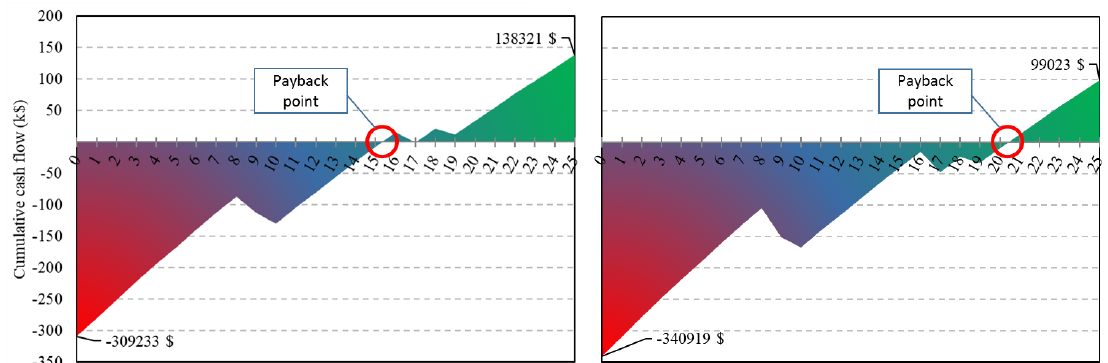
Figure 13. Cumulative cash flow for the PV system with saving target = 50% and feed-in tariff = 3.34 ₵ /kWh. battery capacity =175 kWh ( left ), and 250 kWh( right ).